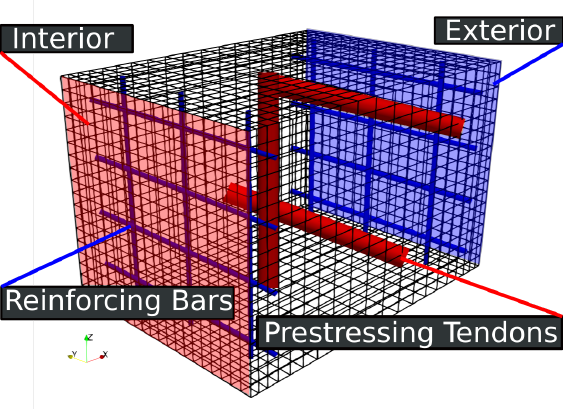
Figure 2. Computational model of the representative section for the structural